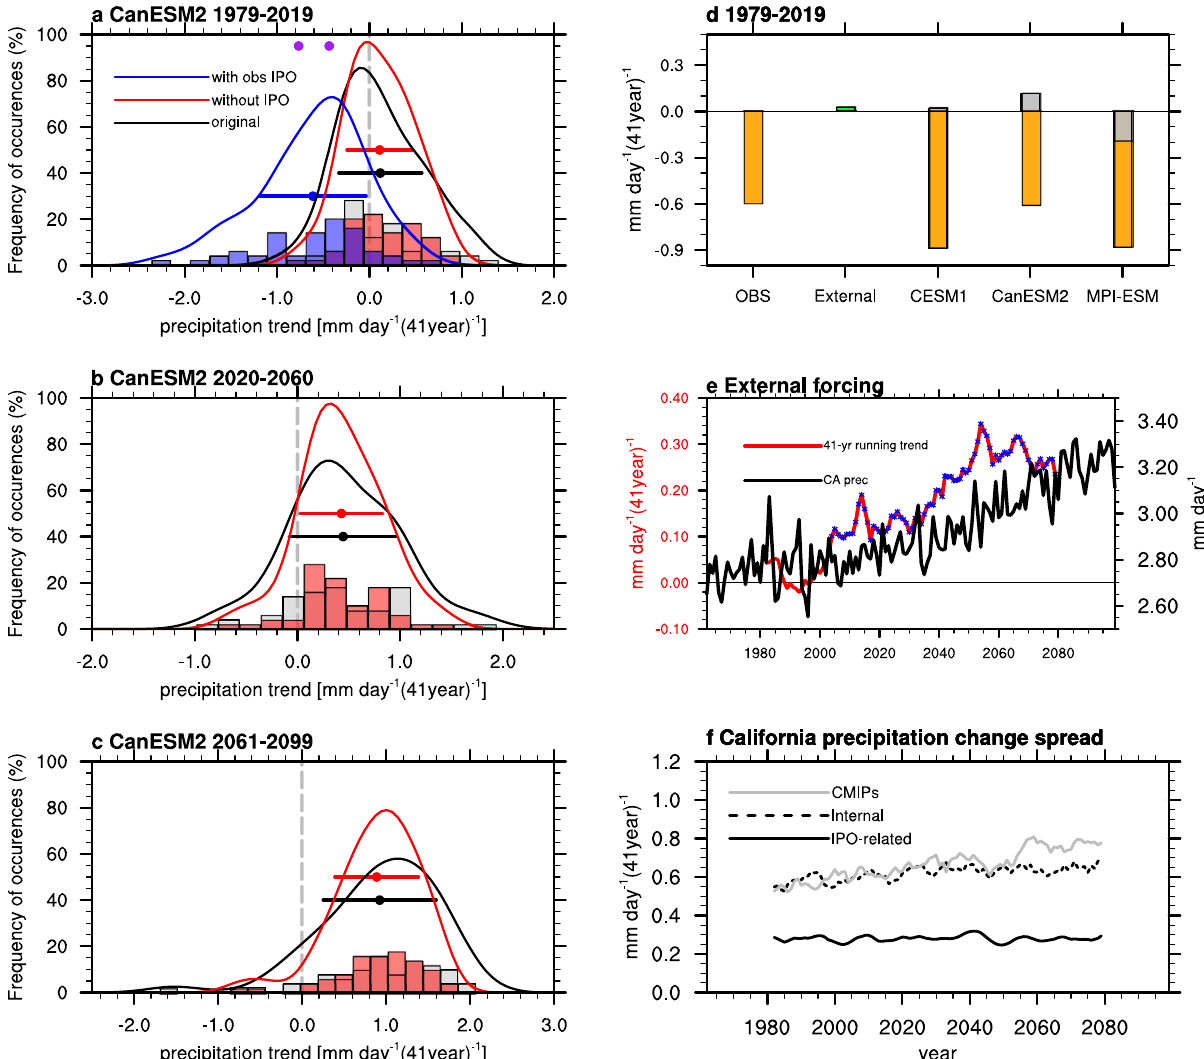
Fig. 3 Constraining the California precipitation decadal trends by the Interdecadal Paci fi c Oscillation (IPO). a – c Histograms (bars) and 100-bin fi tted frequency distribution (lines) of the California winter precipitation trends during a 1979 – 2019, b 2020 – 2060, and c 2061 – 2099 based on 50 members of CanESM2. The gray bars and the black fi tted curves show the frequency of occurrence of the original trends; the red bars and curves are the same but with the IPO ’ s in fl uence removed through linear regression against the IPO index in the individual runs; the blue bars and curves are the same but including the observed IPO trend for 1979 – 2019. The dots and error bars denote the ensemble mean and one standard deviation of the distribution represented by the corresponding color. The purple dots denote the observed precipitation trend based on GPCP ( − 0.44 mm day − 1 41year − 1 ) and CMAP ( − 0.77 mm day − 1 41year − 1 ) datasets. d Linear trend of California winter precipitation during 1979 – 2019. Observation (OBS) is the average of GPCP and CMAP; External is the average of CMIP5, CMIP6, and the three large ensembles (green bar). Trends for the three large ensembles account for the observed IPO trend (orange bars), with the gray bars showing the response to external forcing based on each large ensemble (multi-member mean of each large ensemble). e Time series of California precipitation (CA prec; in mm day − 1 , black, right y -axis) and its 41-year running trend (mm day − 1 41year − 1 , red, left y -axis), with the signi fi cant trend at the 95% level of con fi dence shown in blue dots under external forcing. f Time series of total uncertainty estimated based on the CMIP5 and CMIP6 models (solid grey line), internal variability (dashed black line), and IPO-related internal variability (solid black line) of the 41-year running trend of California